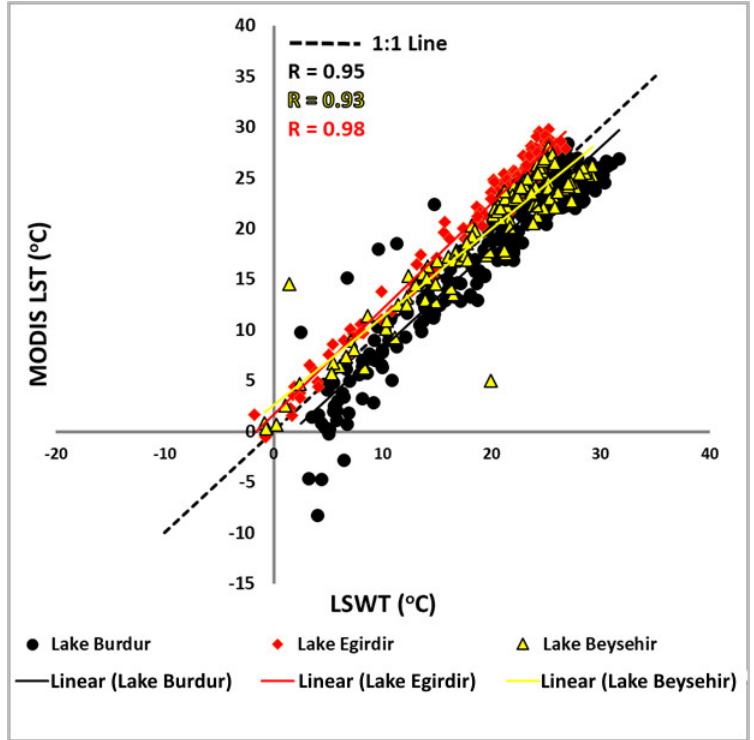
Figure 15. Scatter plot and correlation values between LSWT and MODIS LST for all three lakes.